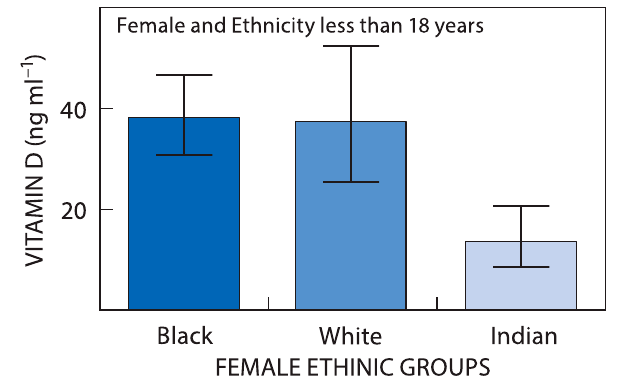
Figure 2: 25(OH)D levels among < 18-year-olds.